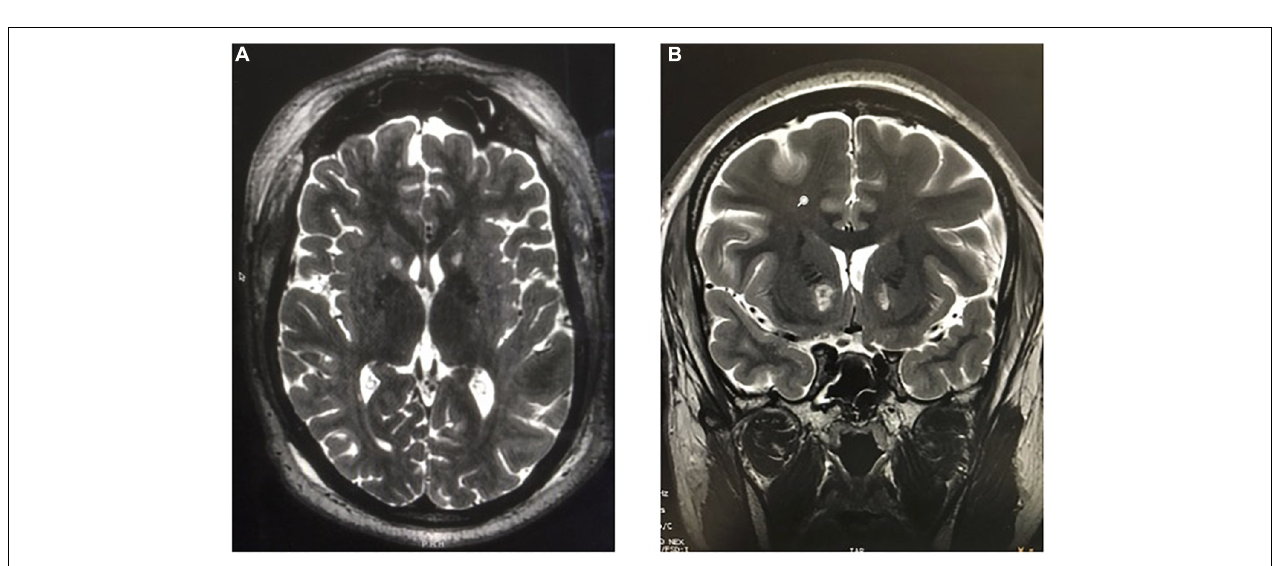
FIGURE 10 | Laser interstitial thermal therapy (LITT) capsulotomy for OCD. (A) Axial, (B) Coronal, and (C) Sagittal MPRAGE MRI images after MR-guided LITT. Original figures kindly provided by Dr. Wael F. Asaad, Brown University.